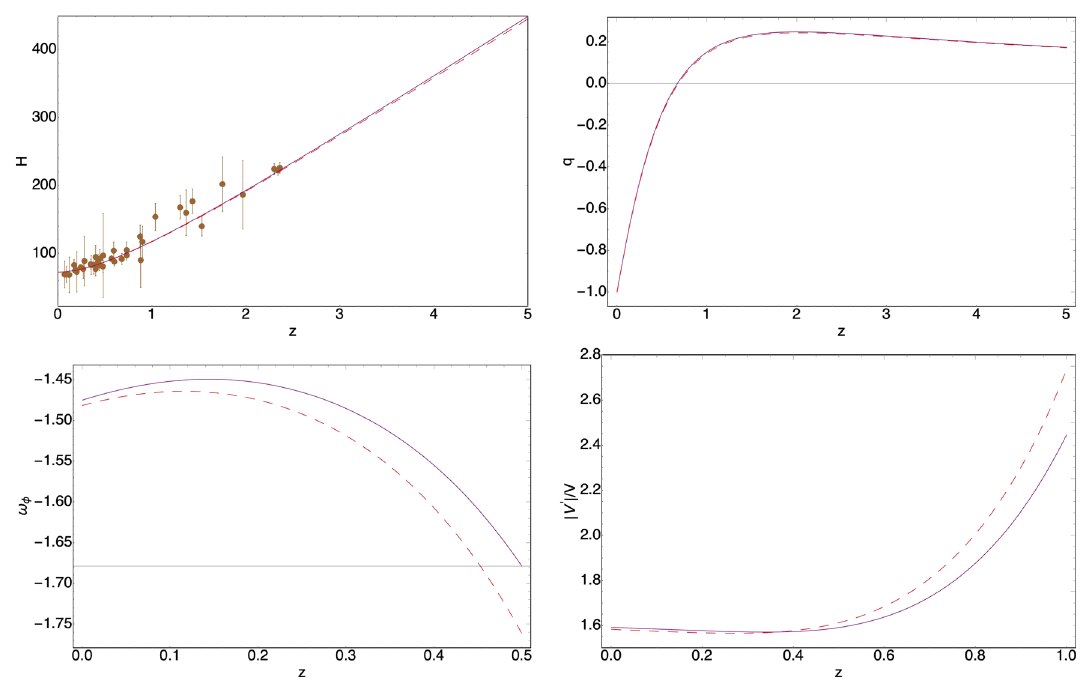
Fig. 2 The graphic behavior of the Hubble parameter in comparison with known H ( z ) data given in Table 1 is presented on the left hand side plot of the top panel. The plot on the right hand side corresponds to the behavior of the deceleration parameter. The left hand side plot of the bottom panel depicts the behavior of the ω φ = P φ /ρ φ equation of state parameter describing the scalar field dark energy model. The right hand side plot of the bottom panel shows the graphical behavior of SC2 Eq. (2). In all cases the purple curve is a plot for the best fit values of the model parameters, when z ∈ [ 0 , 2 . 5 ] , while the dashed red curve